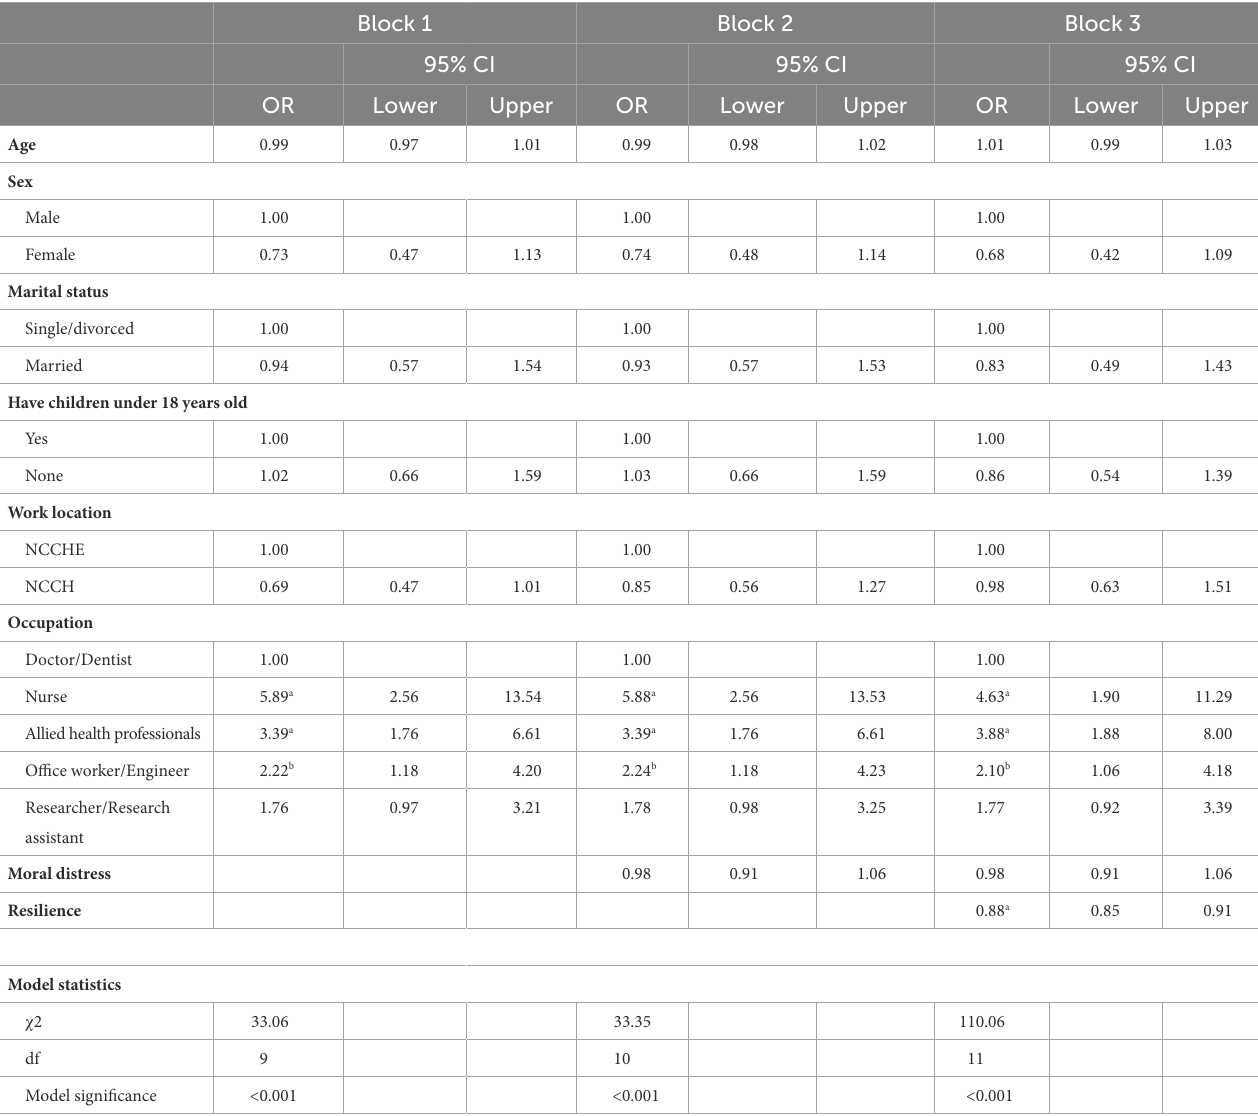
TABLE 2 Hierarchical regression model of factors associated with psychological